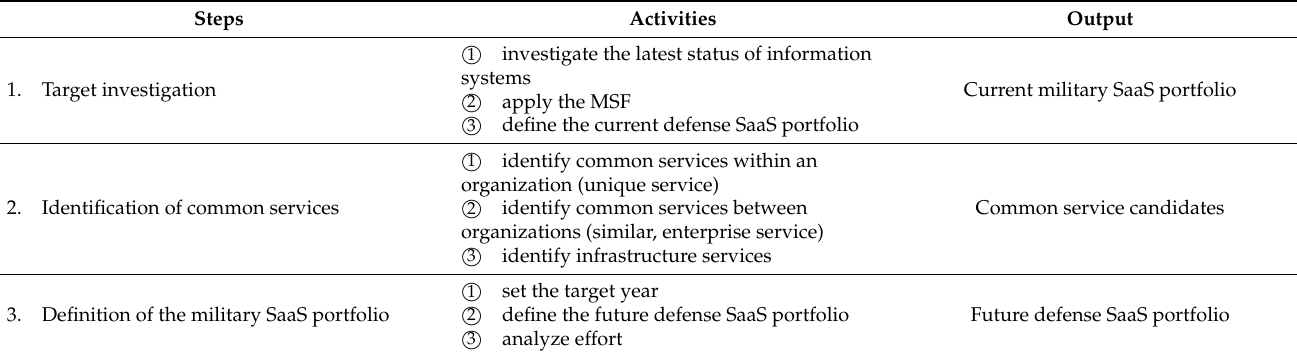
Table 1. Procedure for the creation of military software as a service (SaaS)